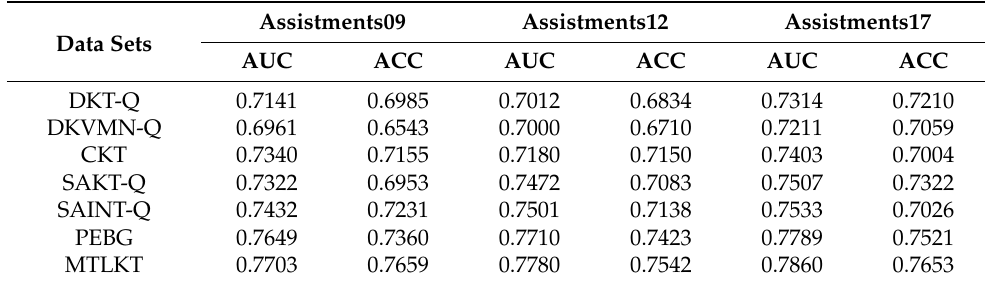
Table 6. Performance of each model on different data sets. Data